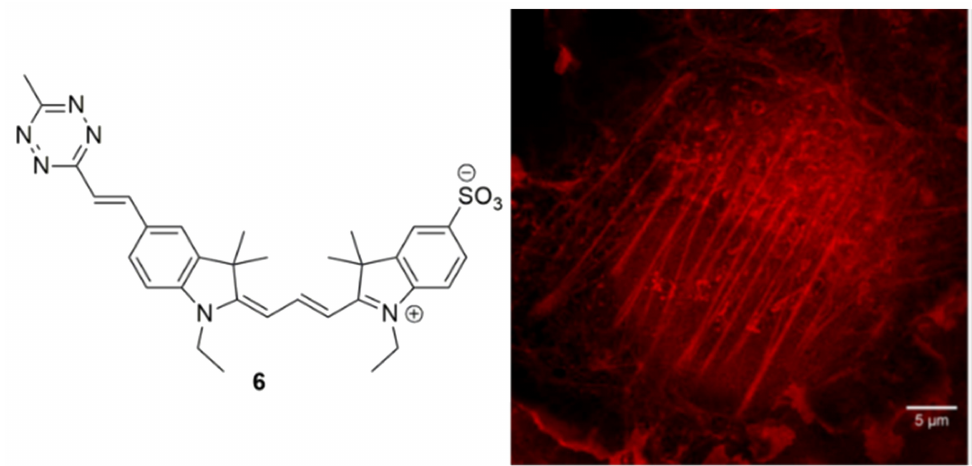
Figure 12. The structure of cyanine 6 and a micrograph demonstrating actin imaging in Cos7 cells after cyclisation with a small peptide. Scale bar = 5 µ m. Reproduced with permission [280]. Copyright 2018 American Chemical Society.